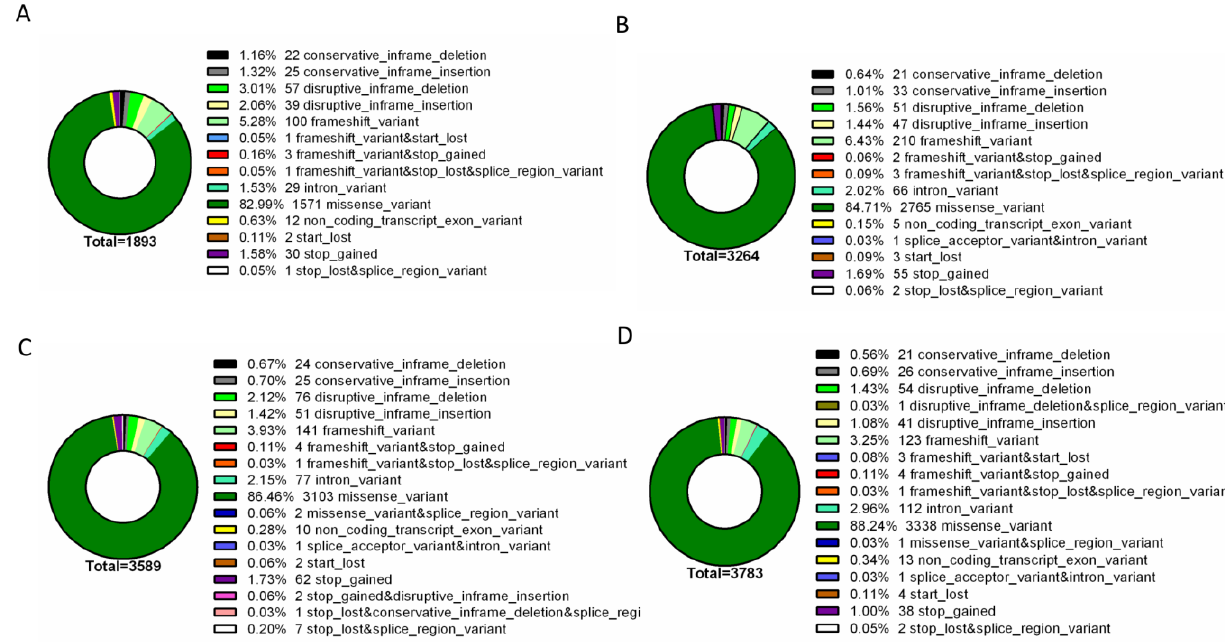
FIGURE 3: Type distribution of genomic variants found exclusively in the genomes of resistant isolates. The assessed mutations are present in the genomes of azole resistant (A) , echinocandin intermediate (B) , echinocandin resistant (C) and multi resistant (D) isolates, being absent from the genomes of susceptible isolates. For each resistance group, the catalogued mutations are specific to that group. Variant type was predicted with SnpEff